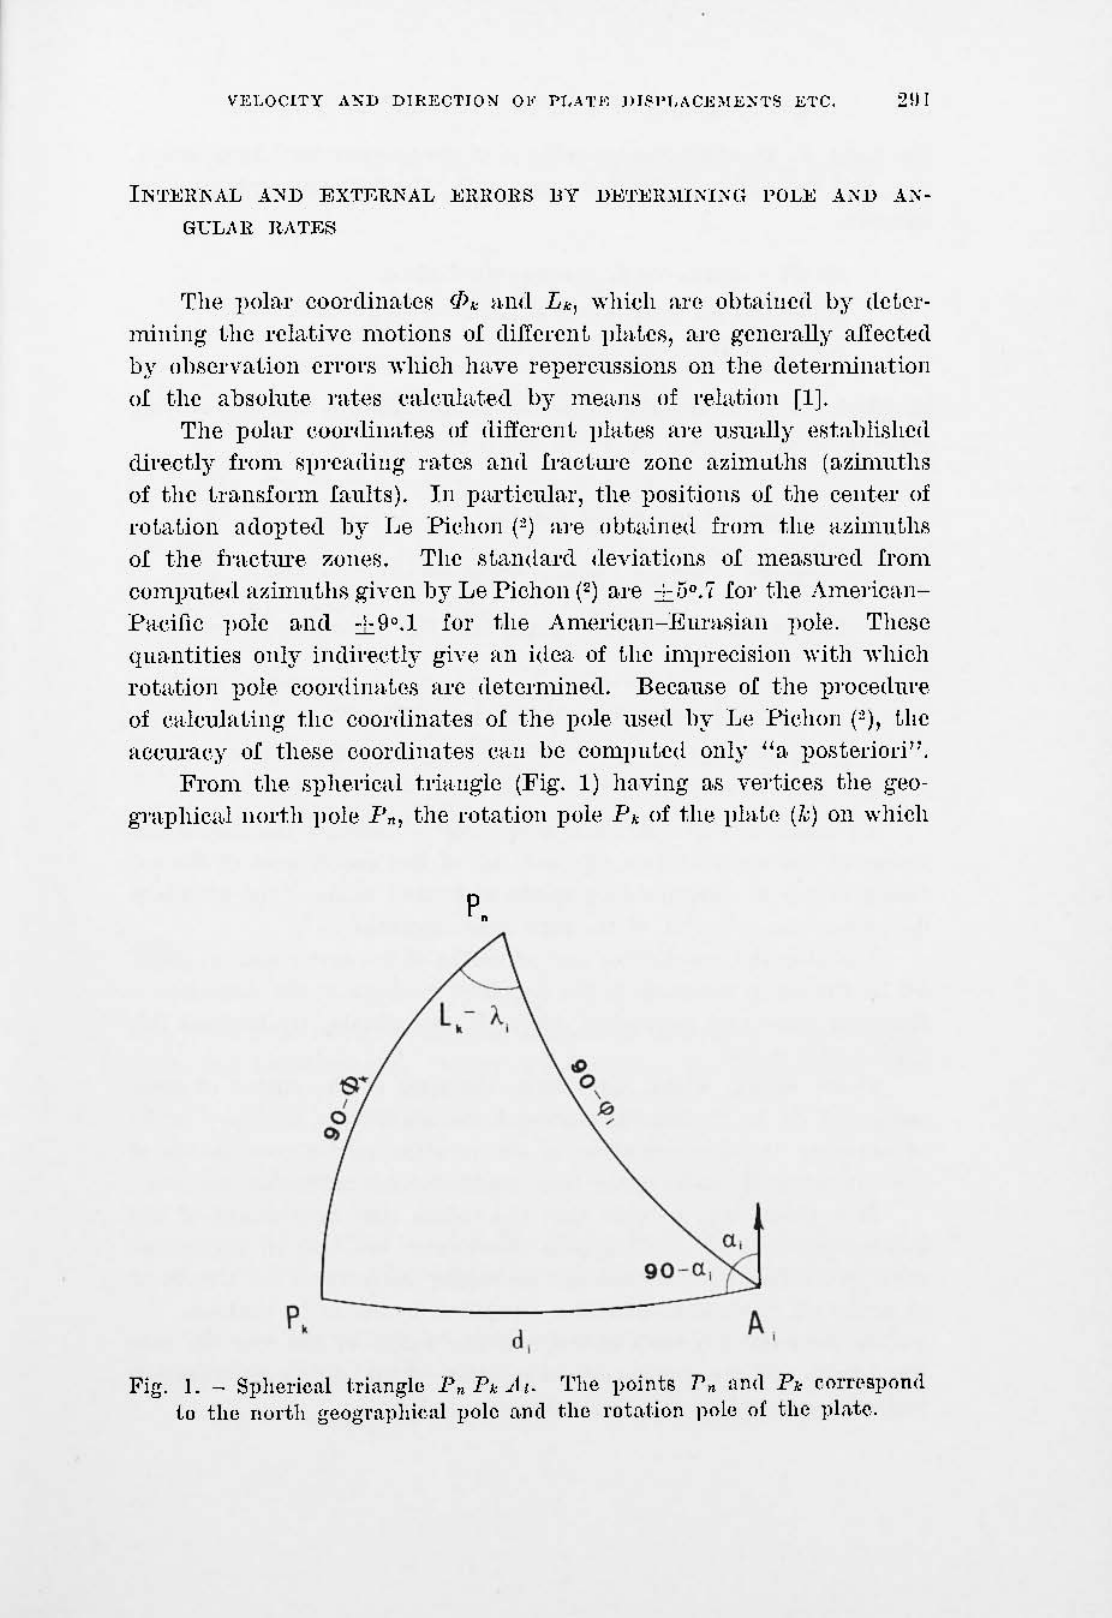
Fig. 1. - Spherical t.rianglo P n l't .AI. LO tho Borth geographkal polo and